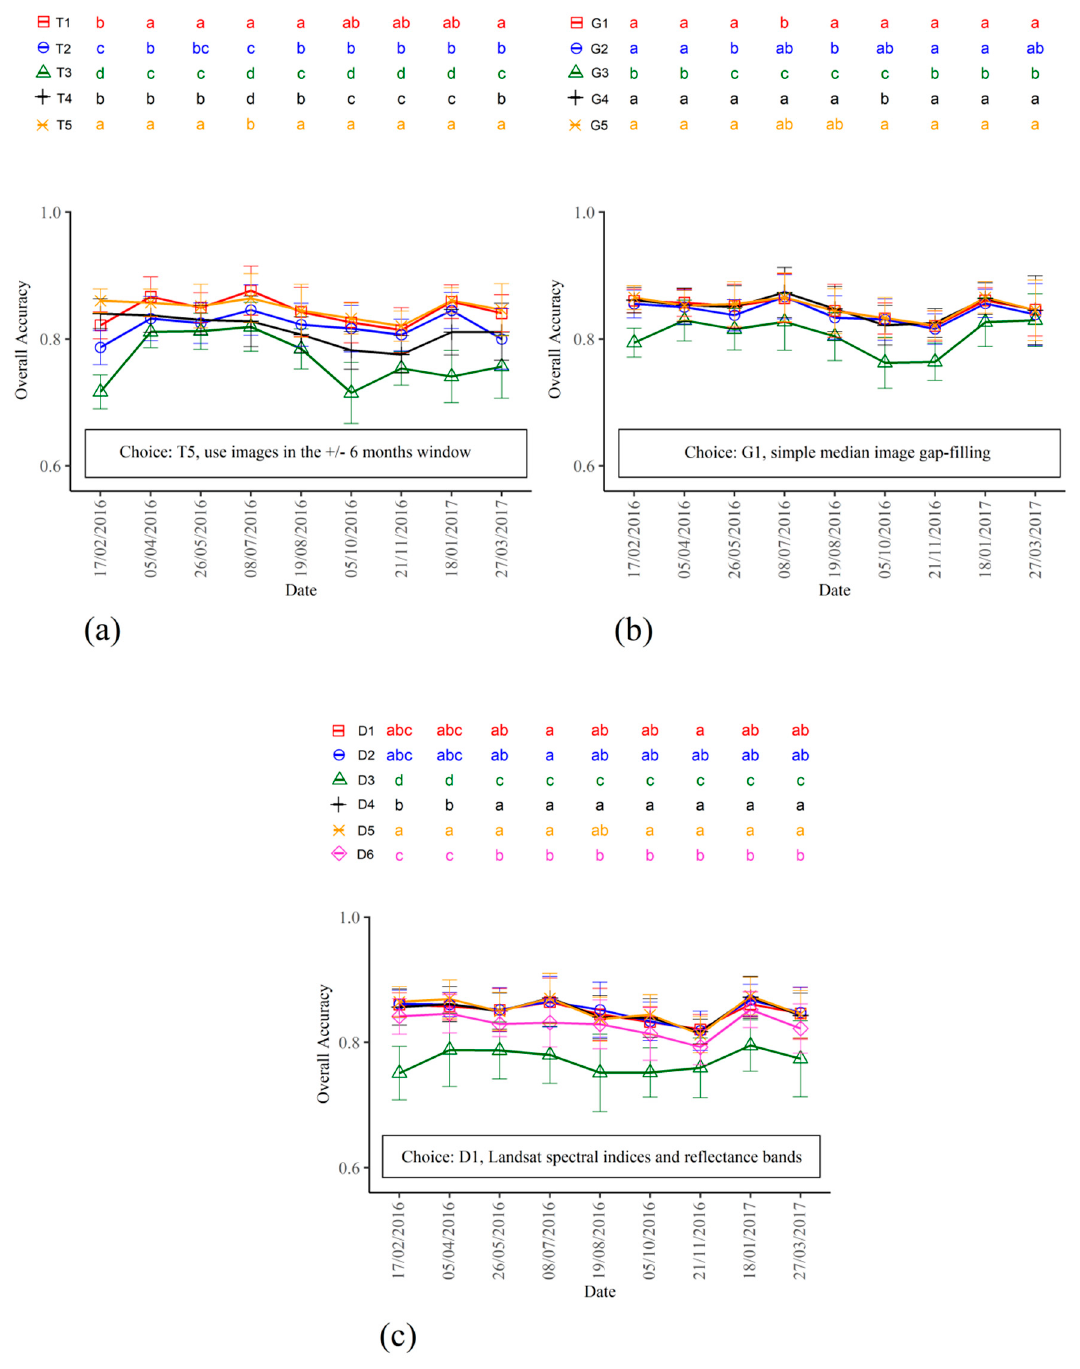
Figure 4. Comparison of the different options described in Table 3 for ( a ) testing the image time-series length ( b ) testing the gap-filling methodology, ( c ) testing the choice of the predictor dataset. The chosen options were T5, G1, and D1, which were used as default options. Legends are fully described in Table 3. Overall accuracies (OA) with one standard error bars are computed for each prediction date, based on a 10-fold cross-validation. The letters refer to multiple comparisons of McNemar’s test, starting with the letter “a” for the highest OA: options having letters in common are not significantly different.